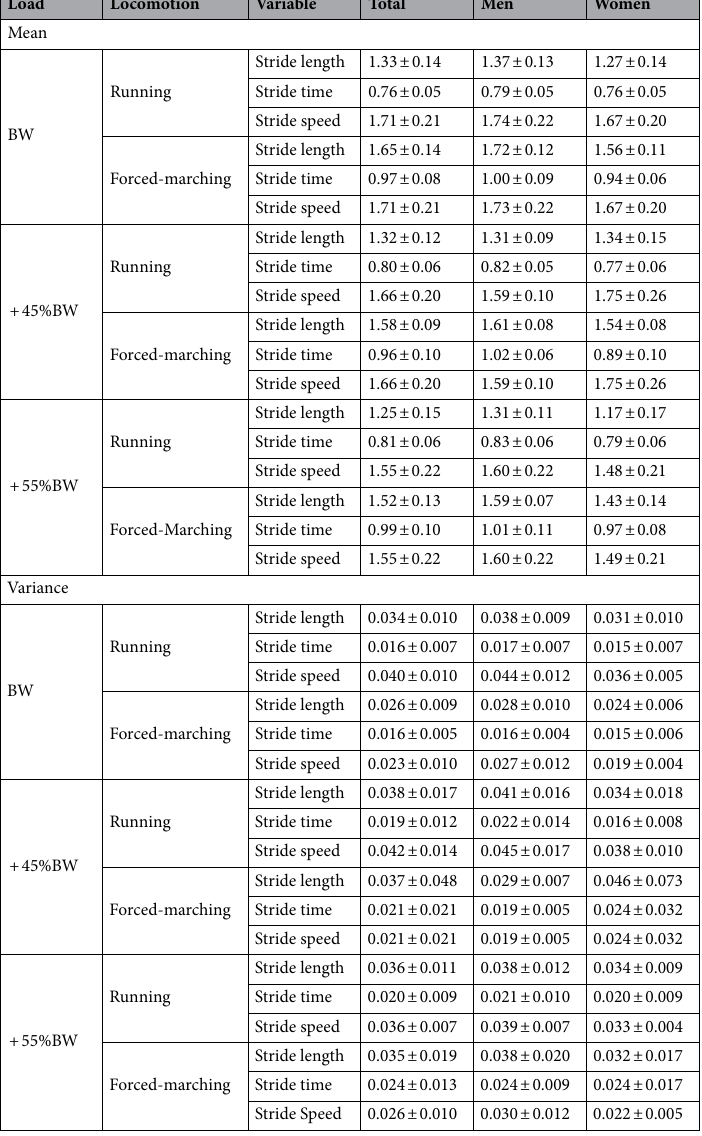
Table 2. Spatiotemporal parameter means and variance. mean ± standard deviation. Stride length in m; stride time in seconds; stride speed in